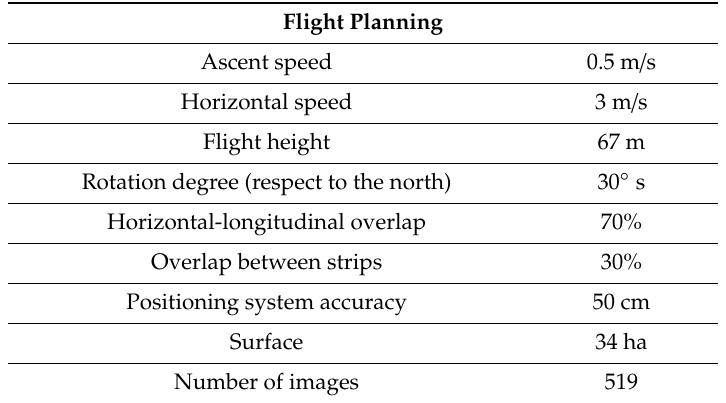
Table 3. Characteristics of the flight planning.